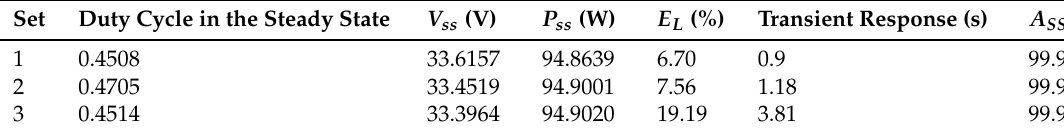
Table 4. Comparison performances under different PSO